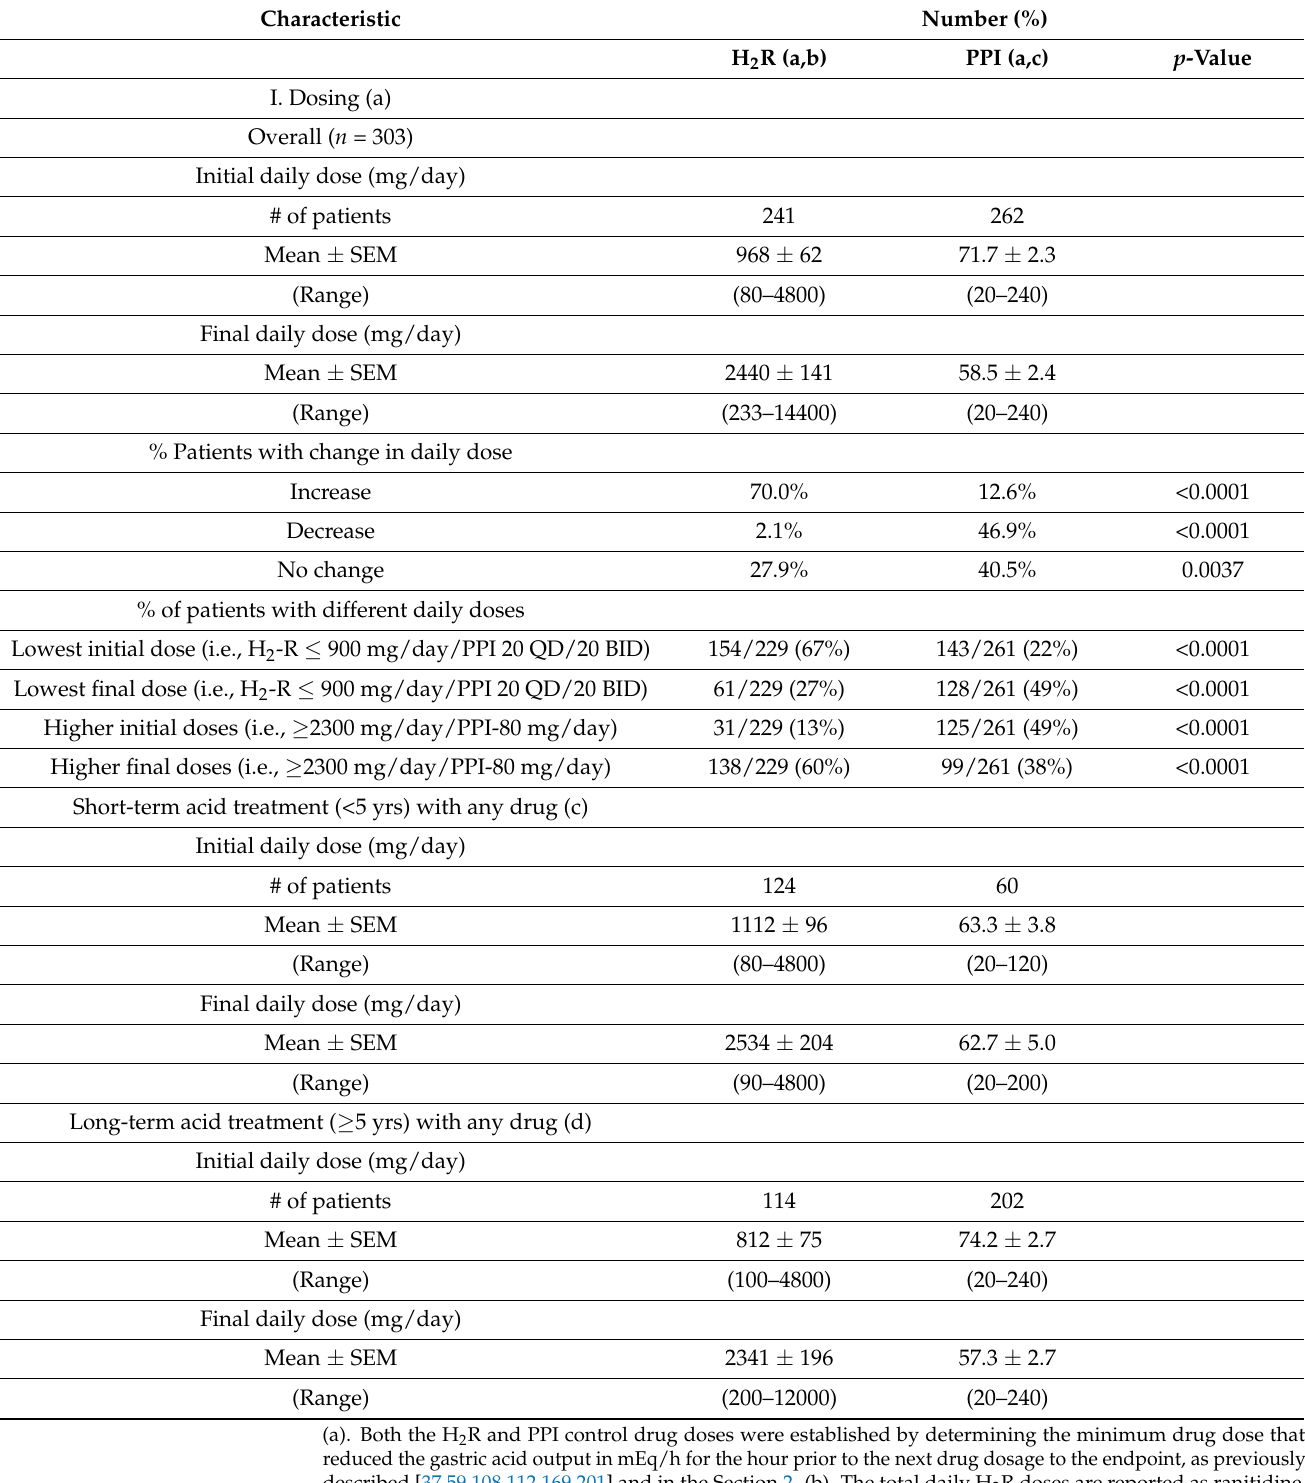
Table 4. Acid treatment: comparison of initial and final daily H 2 R and PPI drug